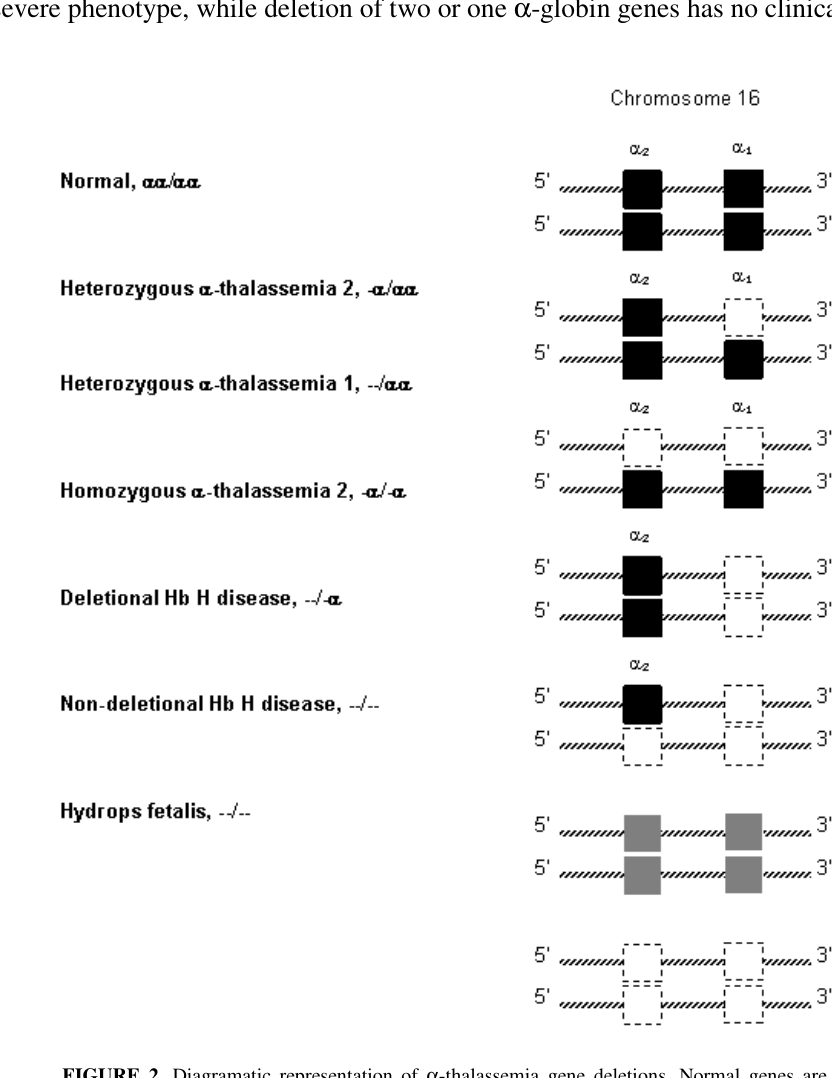
FIGURE 2. Diagramatic representation of α -thalassemia gene deletions. Normal genes are represented by solid black squares ( ■ ), gene deletions by open dashed squares ( □ ), and variable gene expression is designated by solid grey squares ( ■